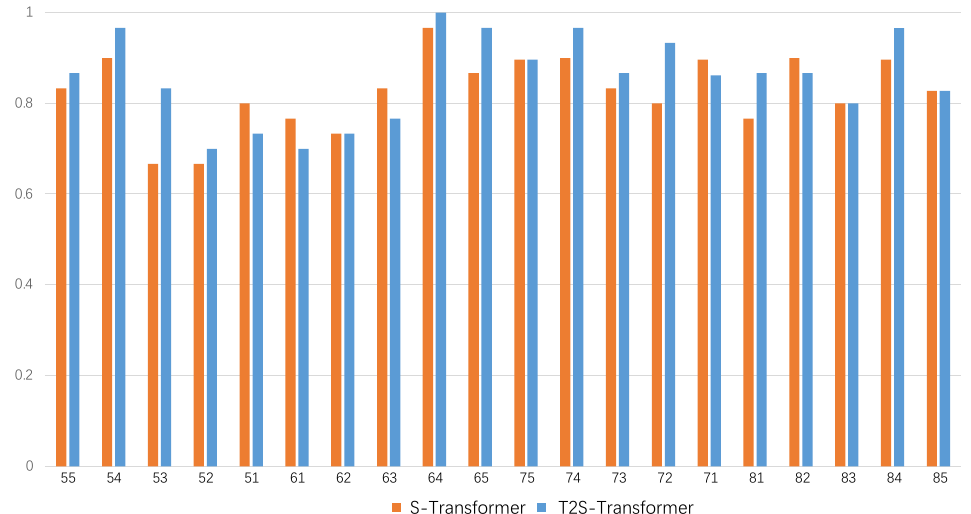
Figure 5. Classification accuracy of each tooth for the proposed T2S-Transformer and the naive S-Transformer. Numbers in the horizontal ordinate denote the tooth positions.